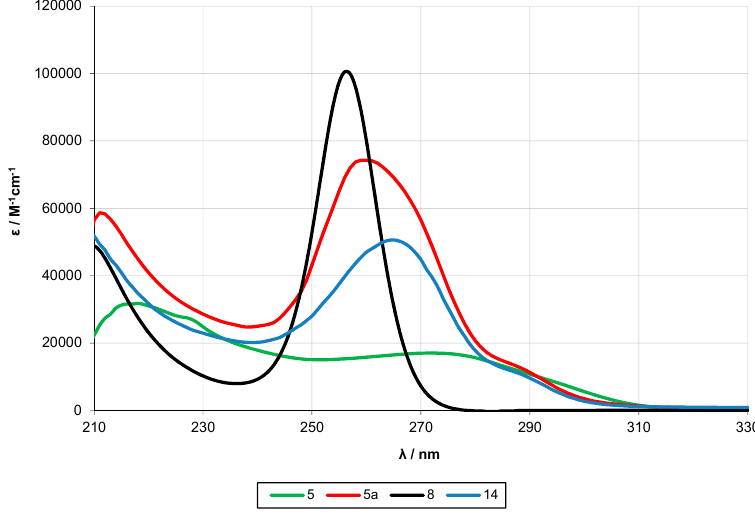
Figure 9. Comparison of the UV spectra of different dodecasilanes ( 5 , 5a , 14 ) and compound 8 .